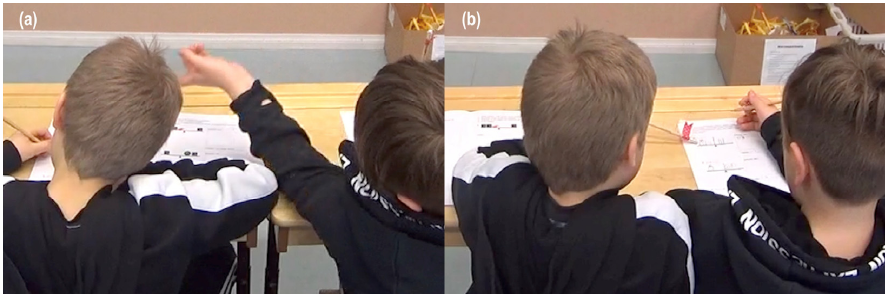
Figure 4. Peer communication and scaffolding. ( a ) St 10 (C) (on the right) asking for help from St 9 (B) (on the left) and pointing at his groupmate’s worksheet but receiving no reaction from St 9 (B). ( b ) Later, St 9 (B) explaining to St 10 (C) by speaking and pointing at his groupmate’s worksheet.